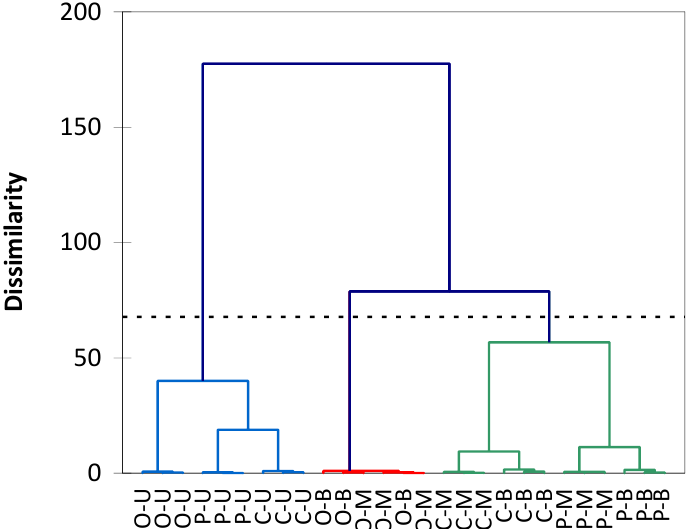
Figure 4. Dendrogram provided by the Agglomerative Hierarchical Cluster Analysis (AHCA) applied to observations in the experimental sites immediately after the prescribed fire and mulching treatment (Samo, Calabria, Southern Italy). Legend: P = pine; C = chestnut; O = oak; U = unburned; B = burned and not treated; M = burned and mulched; the y -axis of the dendrogram reports the similarity level, while the dotted line the clustering level.